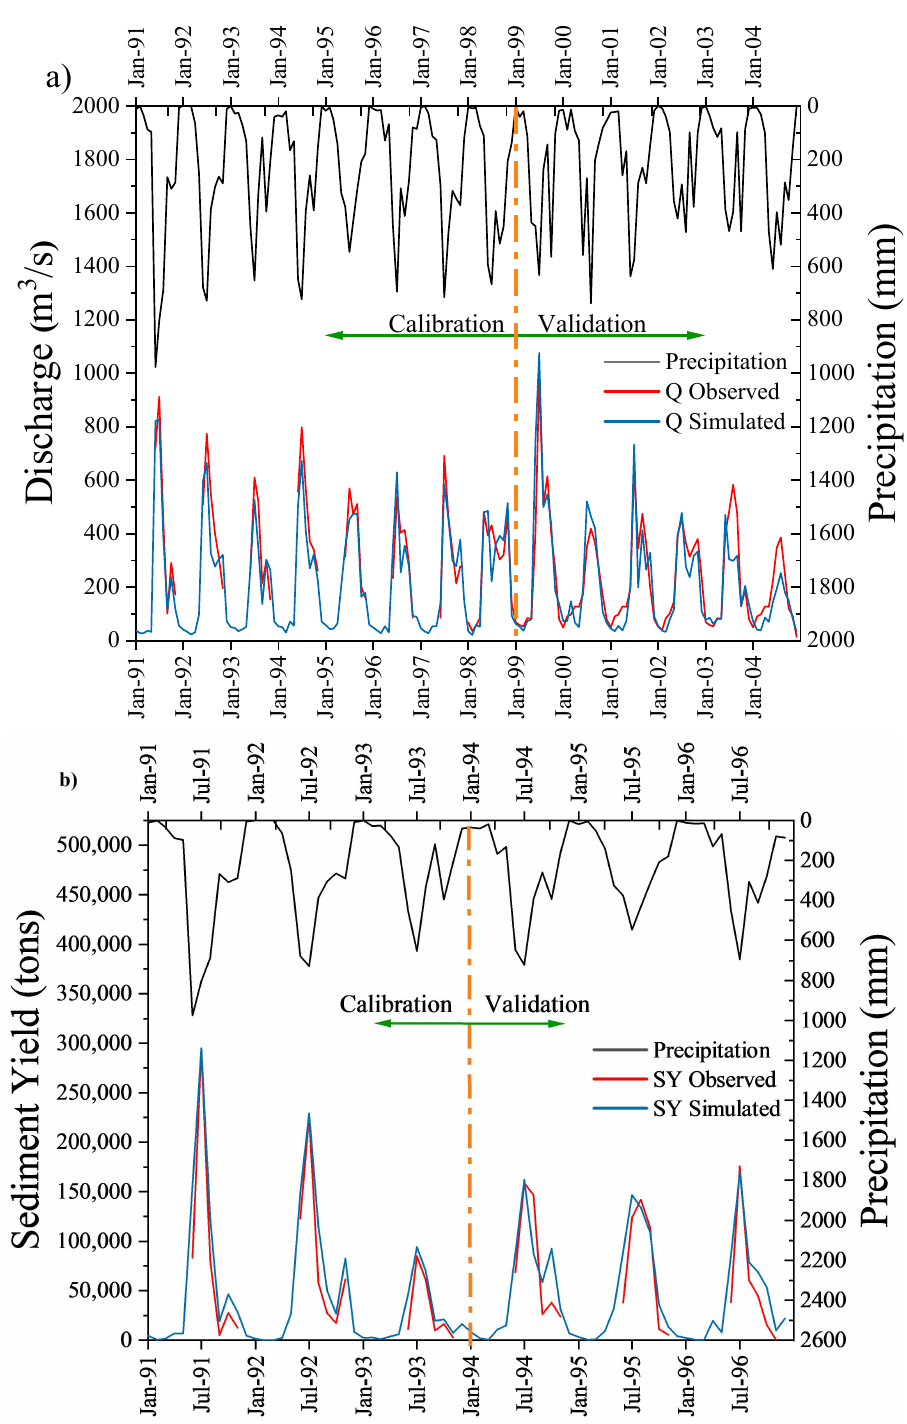
Figure 4. Calibration and validation for ( a ) streamflow (1991–2004) and ( b ) sediment yield (1991–1996) at Neeleshwaram gauging station of PRW. Note: the streamflow data during the dry months (December through May) were not available for 1991–1998.